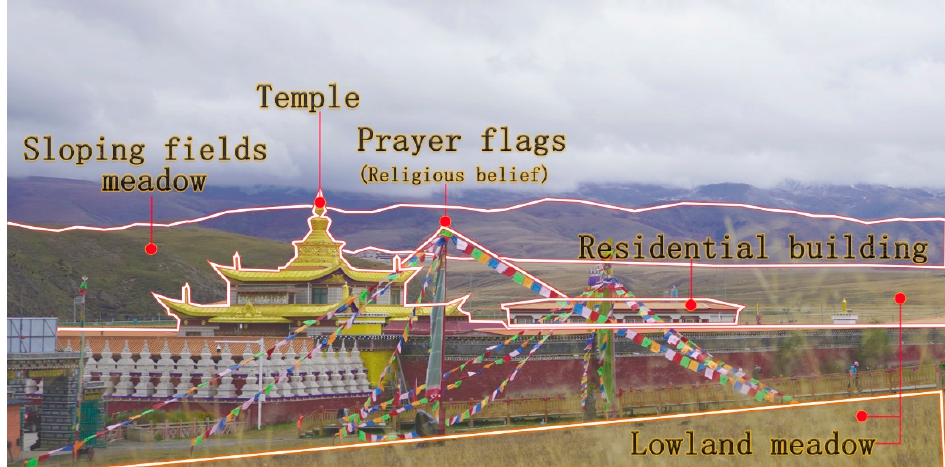
Figure 3. Landscape classification methods. Table 4. Overall landscape preference